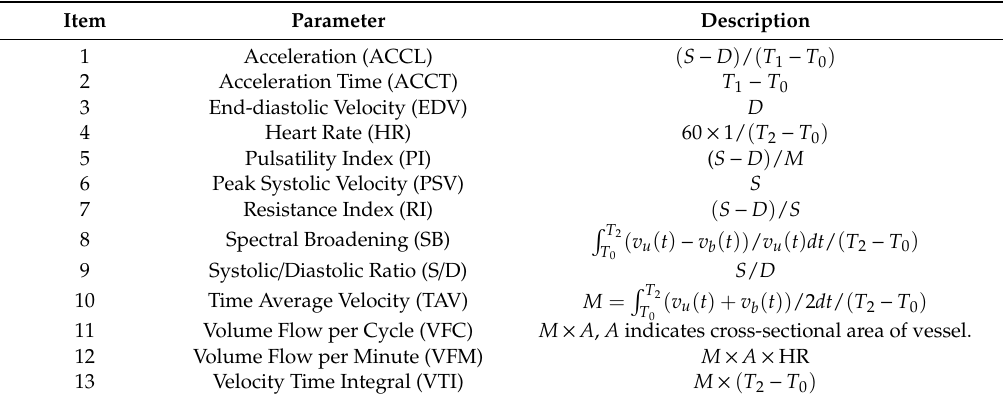
Figure 1. Spectrum and envelope curves. Table 1. List of hemodynamic parameters.